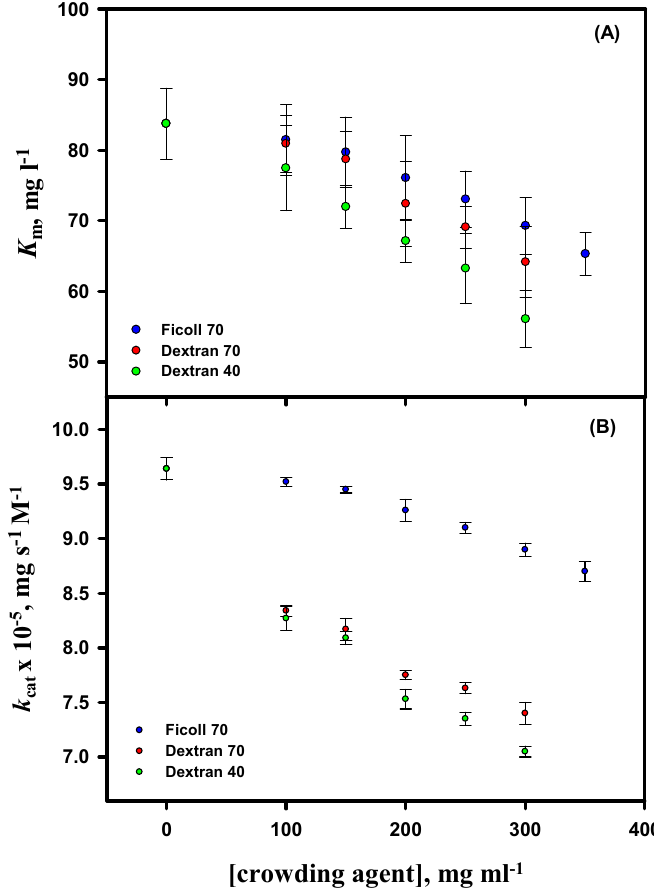
Figure7. Plotsofkineticparameters K m (panel A )and k cat (panel B )oflysozymeversustheconcentration of the crowding agent at pH 7.0 and 25 ◦ C. Ficoll 70, dextran 70, and dextran 40 represent blue, red, and green circles, respectively. The results for ficoll 70 and dextran 70 are taken from our previous published